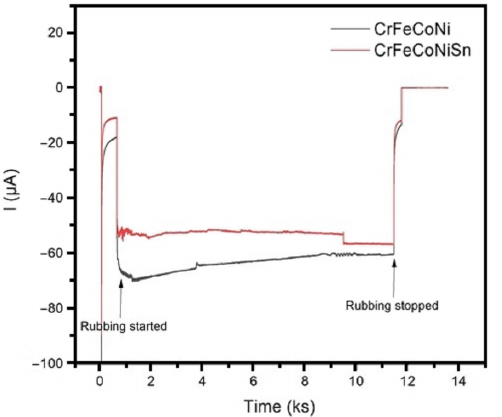
Figure 10. Cathodic current flowing in tribocorrosion testing for CrFeCoNi and CrFeCoNiSn alloys tested in 0.6 M NaCl solution at ambient temperature.